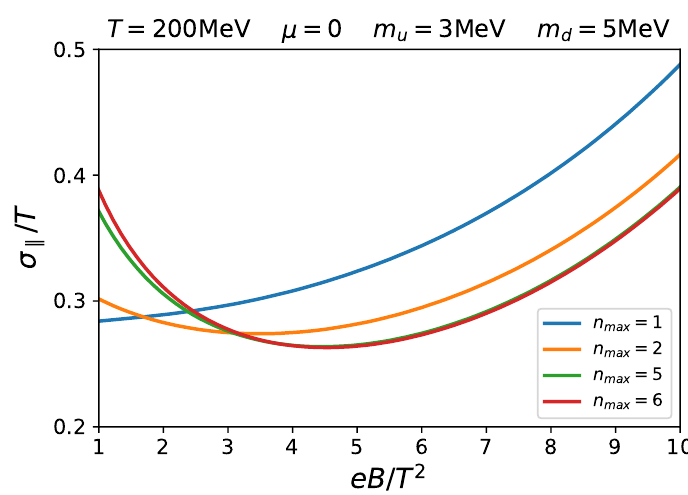
Figure 6 . Magnetic dependence of the longitudinal electric conductivity for two favor case for various n max